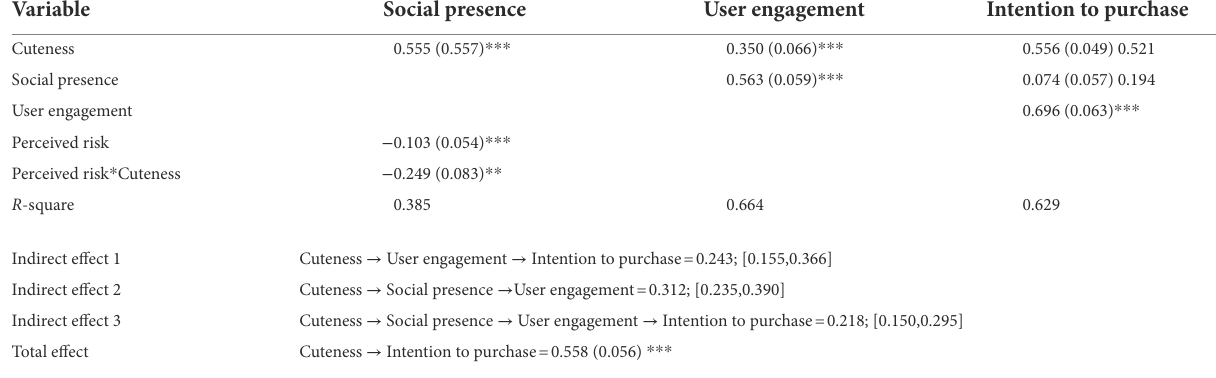
TABLE 6 Summary results for the moderated mediation